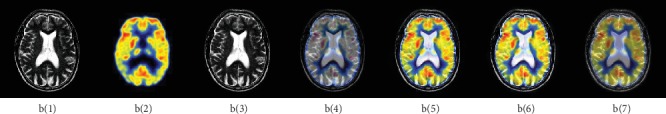
Examples of MRI-PET medical image fusion, b(1) and b(2) are MRI and PET source images, respectively. b(3)~b(7) are the fused images of GFF [81], MSA [82], NSCT+LE [85], NSST+PAPCNN [26], and ESF+CSF [78], respectively.